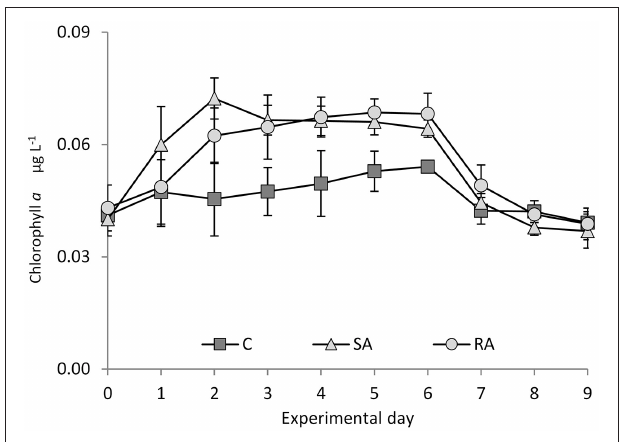
FIGURE 5 | Chlorophyll a concentration during the mesocosm experiment. Cnt = Control mesocosms (no addition), SA = single addition, mesocosms where dust was added once, on the first day of the experiment, RA = repetitive addition, mesocosms where the same quantity of dust was added, divided into three doses, on the first 3 days of the experiment, Days 0, 1, and 2. Data are mean ± SD of three replicates. This Figure is from Lagaria et al. (2017) , this SI, mod.